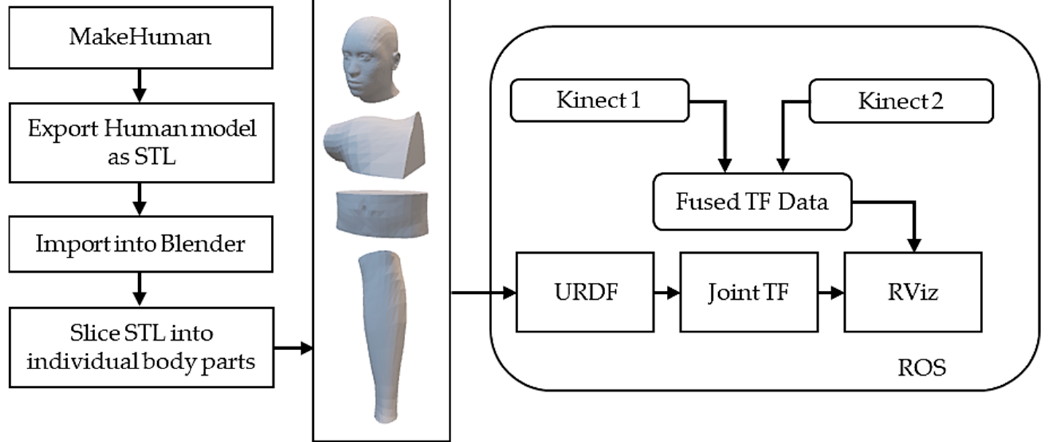
Figure 8. Process of creating a human model for visualisation in RViz.